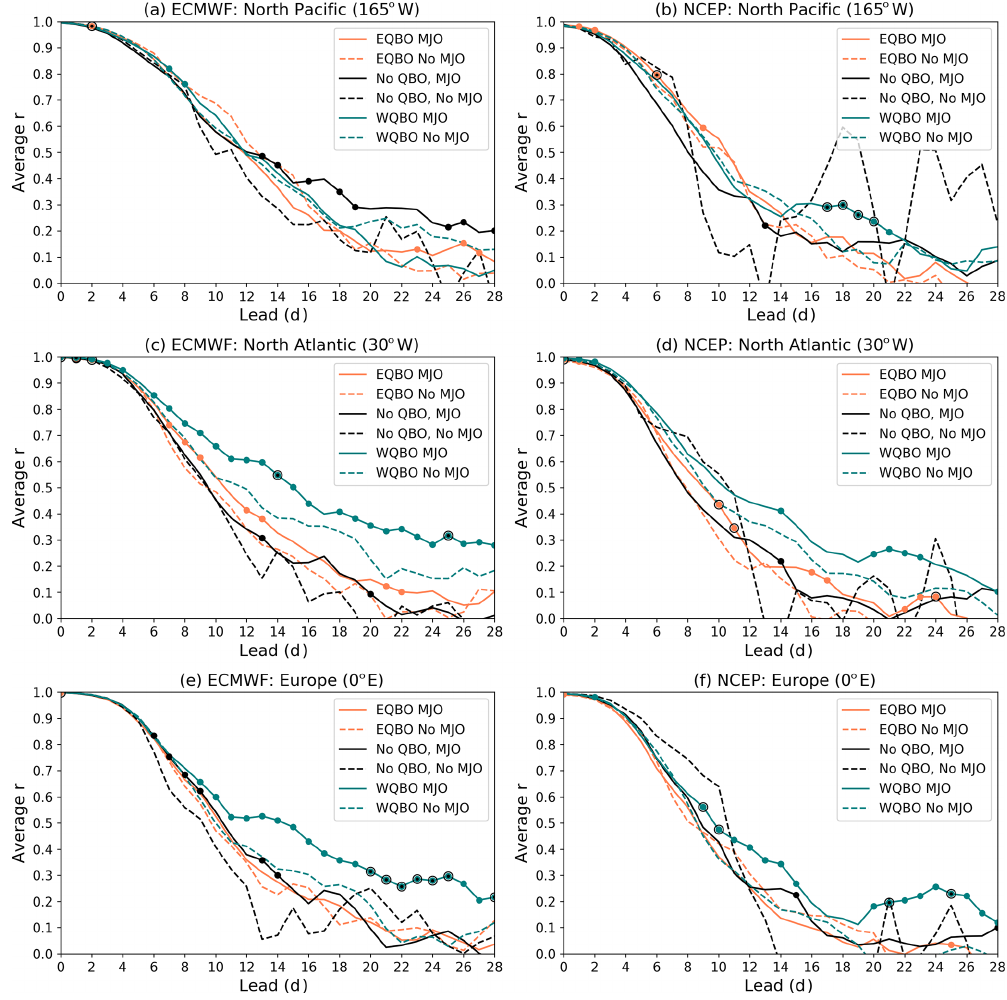
Figure 4. Anomalous spatial correlation coefficient at (a, b) 165 ◦ W, (c, d) 30 ◦ W, and (e, f) 0 ◦ E for (a, c, e) ECMWF and (b, d, f) NCEP. Solid lines correspond to active MJOs while dashed lines correspond to inactive MJOs. Colors refer to the phase of the QBO. Colored dots denote regions and leads where requirement one is passed at 90% confidence for the corresponding QBO. Black circles indicate regions and leads where requirement two is passed at 90% confidence, and small black dots on orange and teal lines indicate regions and leads where requirement three is passed at 90% confidence. See the text for